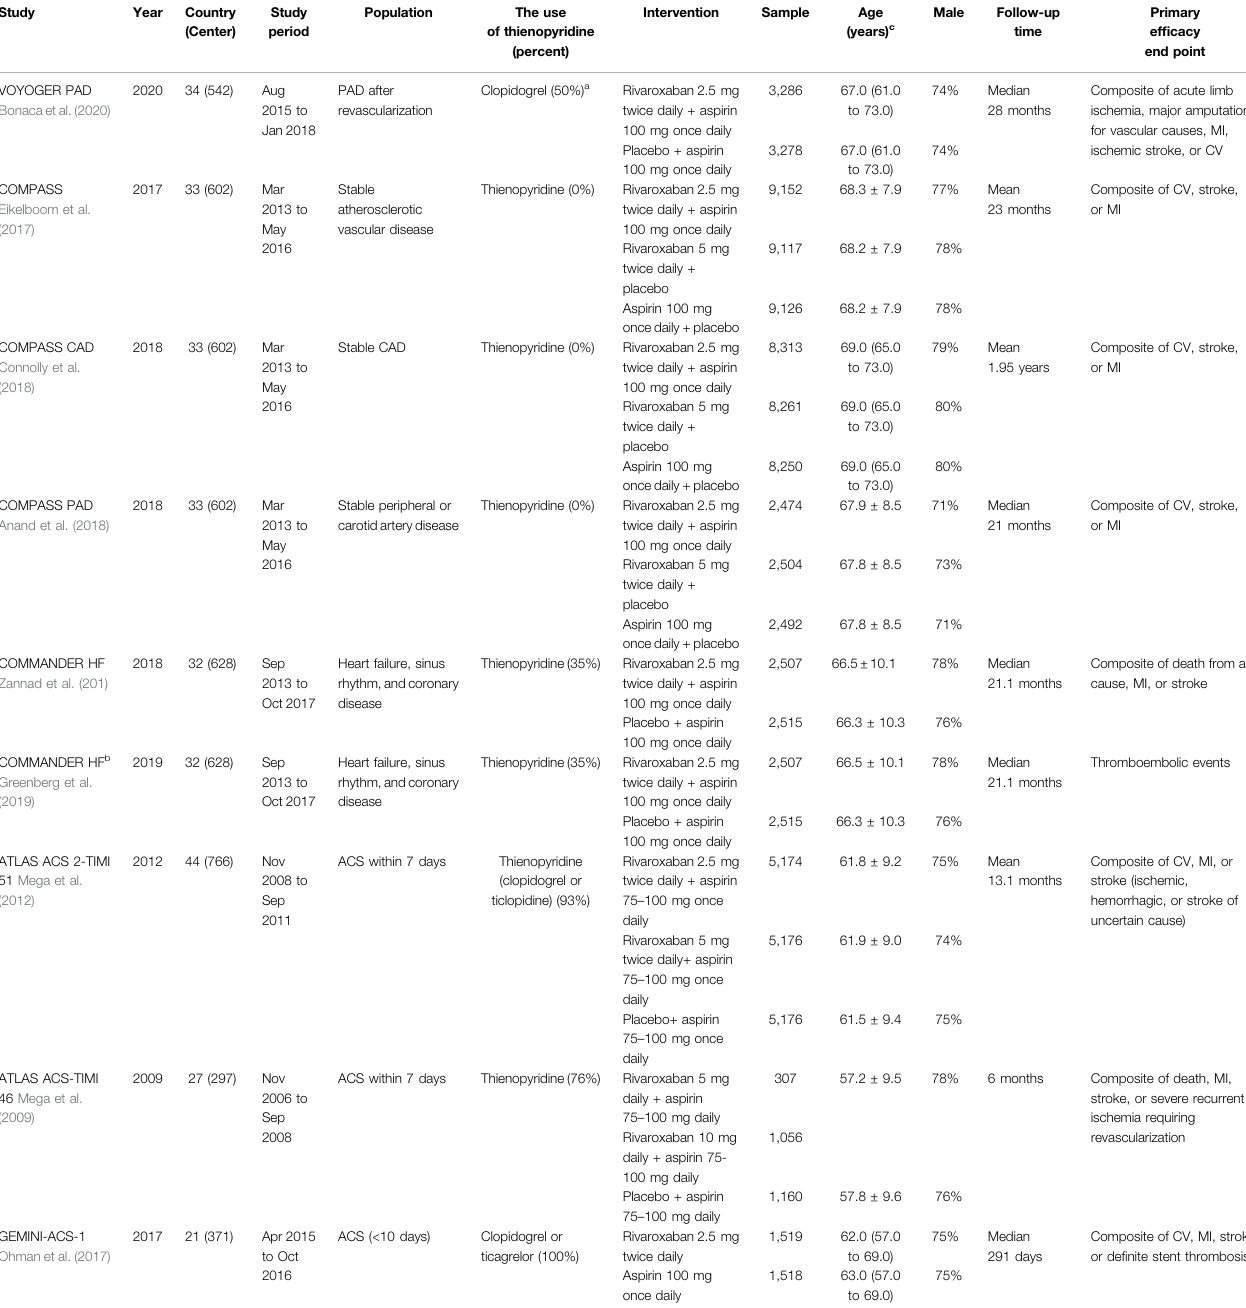
TABLE 1 | The basic characteristics of the eligible studies.